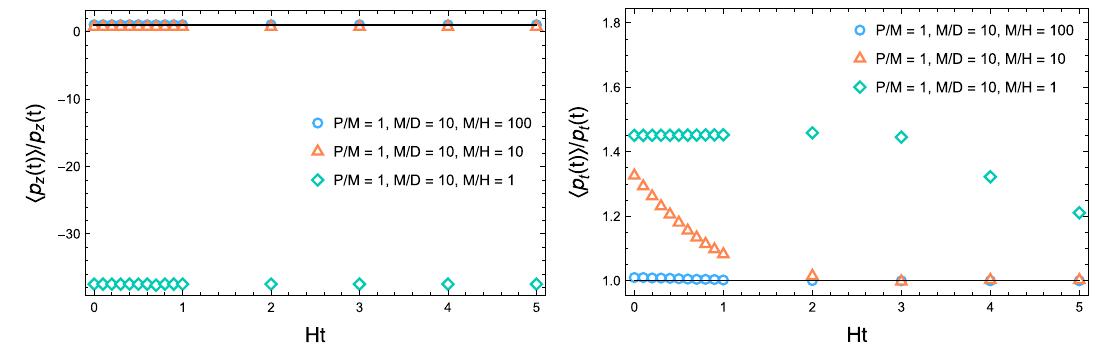
the wave-packet momentum (cid:7) p z ( t ) (cid:5) . In the case of M / H = 1, the ratio (cid:7) p t ( t ) (cid:5) / p t ( t ) appears to be oscillating around 1.165 at Ht ∈ { 6 , 7 ,..., 19 , 20 } with the amplitude